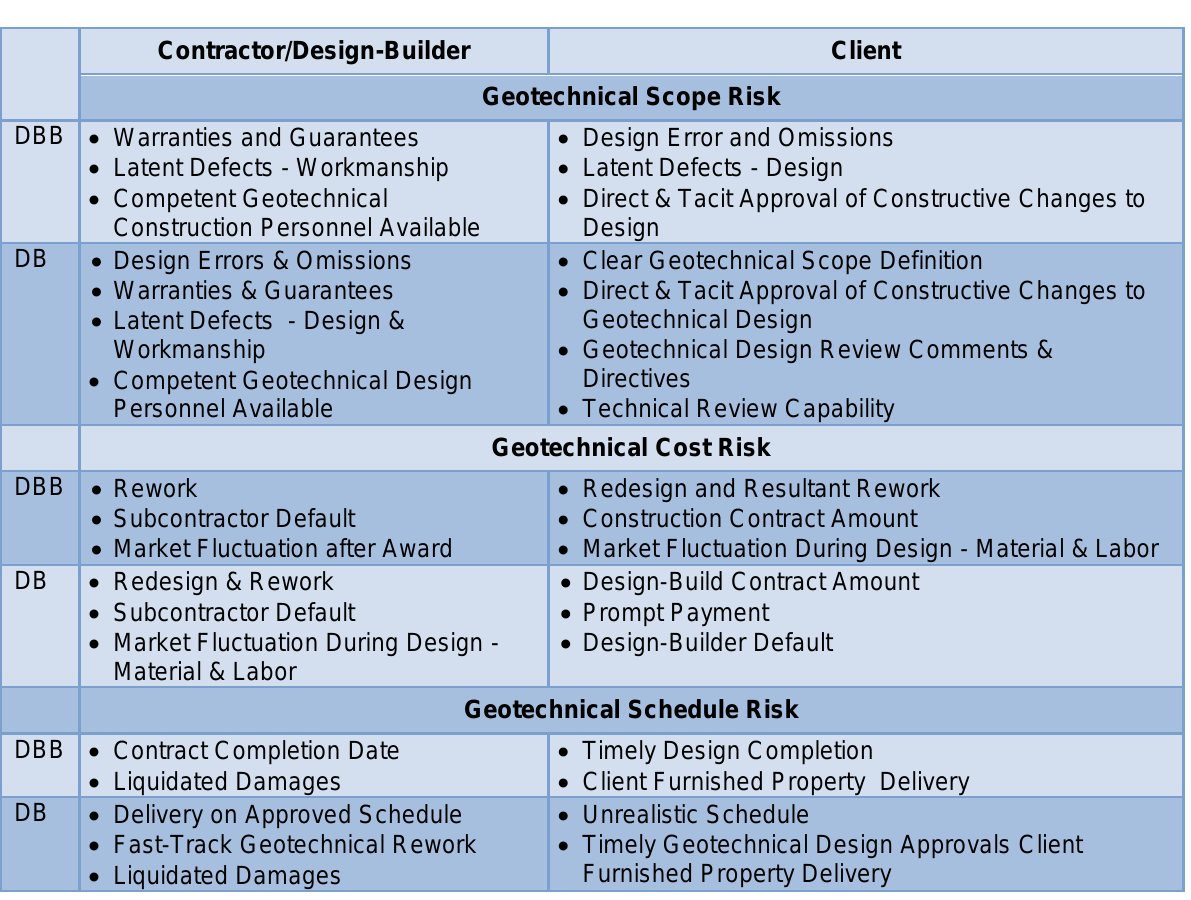
Table 1 DBB versus DB risk